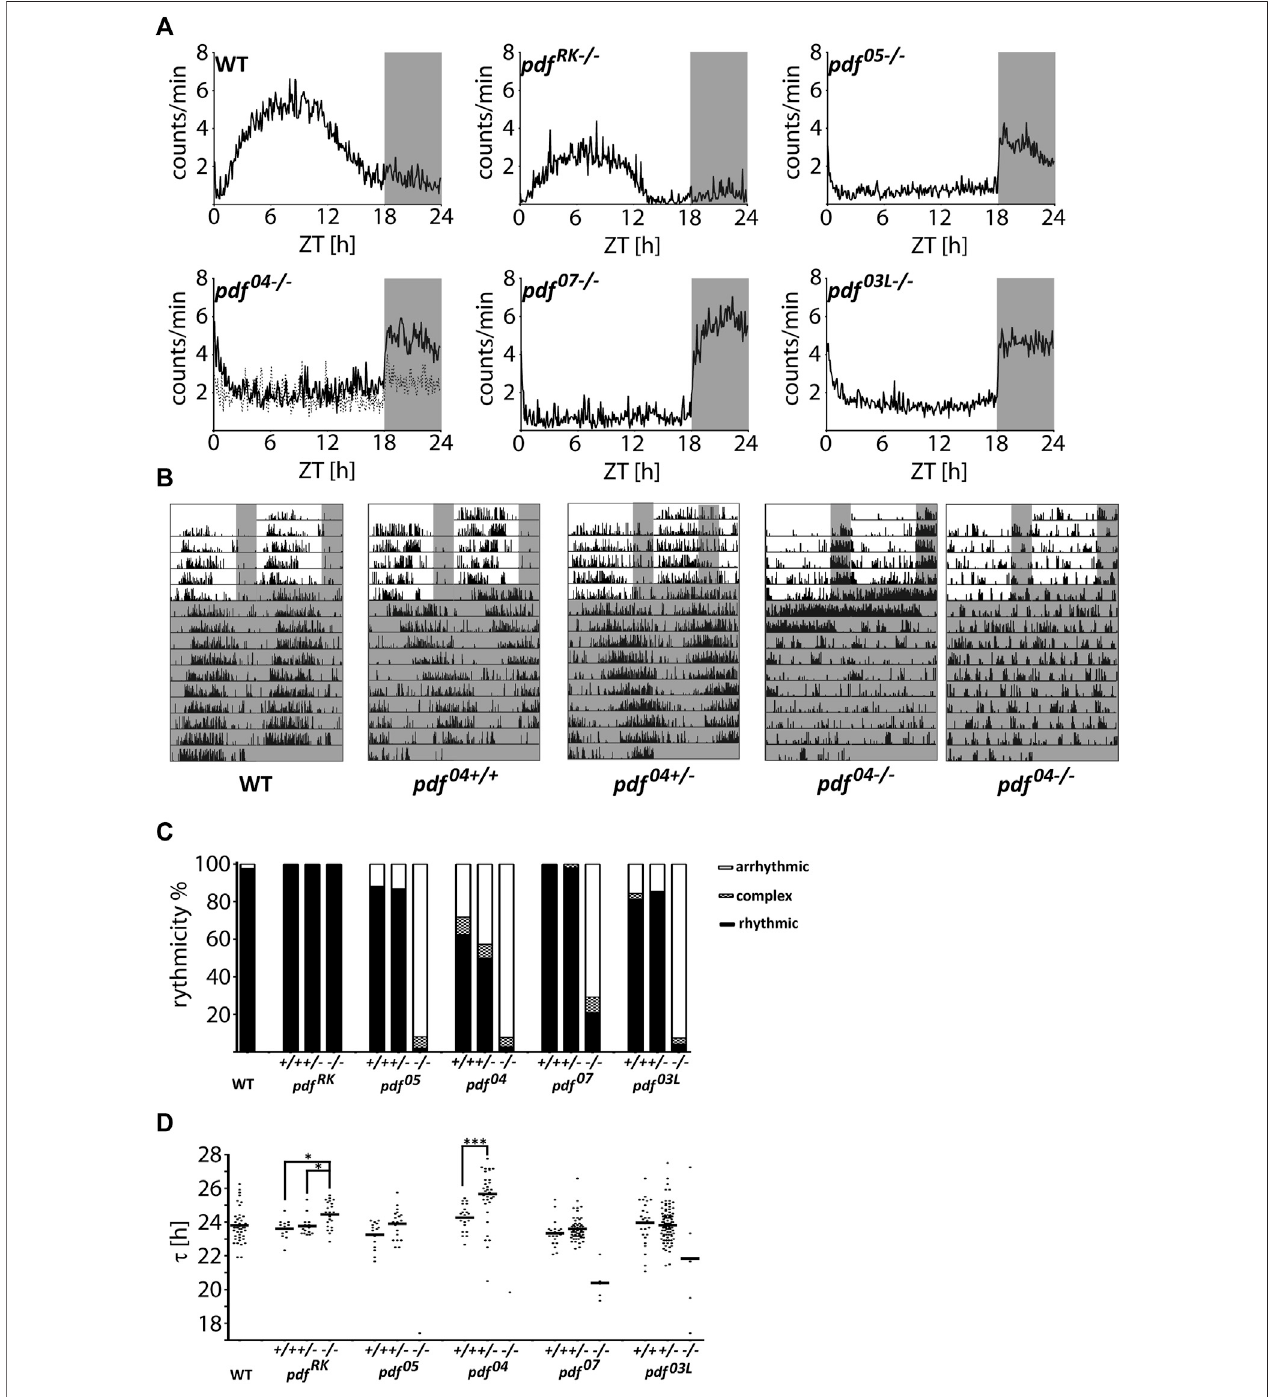
FIGURE 3 | Locomotor activity of P. apterus pdf mutants. (A) The average daily activity of WT and pdf mutants in LD 18:6 cycles. Each graph represents the averageactivityofallbugsscoredas “ rhythmicinLD. ” Dashedlineinthegraphrepresenting pdf 04 − / − mutantshowstheaverageactivityofallbugsscoredas “ arrhythmic in LD. ” (B) Representative actograms of WT, pdf 04+/+ , pdf 04+/ − , and, pdf 04 − / − bugs. Both types, nocturnal and arrhythmic in LD are shown in case of pdf 04 − / − . Grey rectangles on graphs and actograms depict darkness. (C) Summary of the behavioral rhythmicity of WT and pdf mutants in DD. (D) Free-running period ( τ ) of rhythmicanimals.Everydotrepresentsameasurementfromasingleindividual,thehorizontalbarrepresentsmean.Statisticaldifferencesaremarkedby(*) p < 0.05,(***) p <